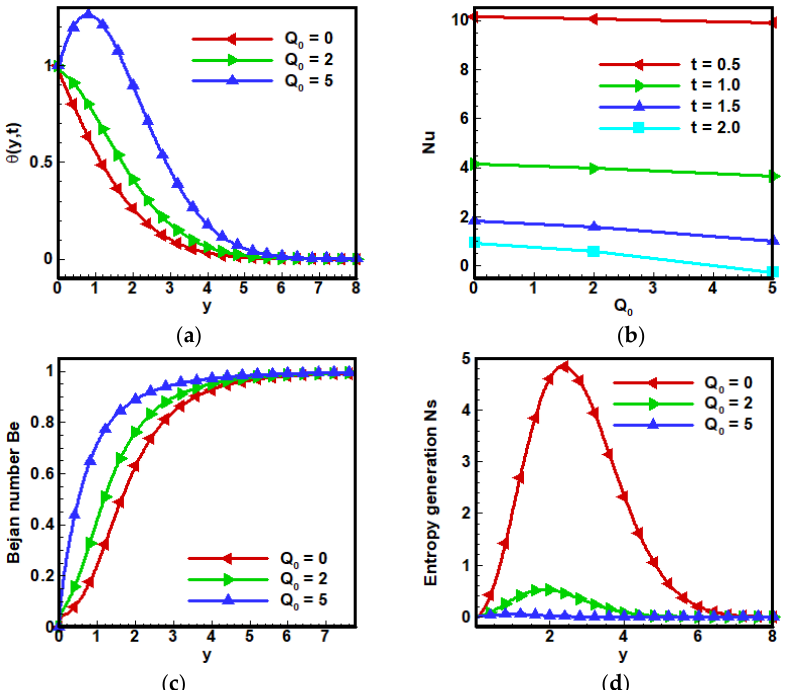
Figure 9. Influence of heat source 𝑄 (cid:2868) on ( a ) dimensionless velocity profile ( b ) non-dimensional tem- Figure 9. Influence of heat source Q 0 on ( a ) dimensionless velocity profile ( b ) non-dimensional perature profile ( c ) Bejan number and ( d ) entropy generation when Λ (cid:2869) = 0.6,Λ (cid:2870) = 0.5,𝐺𝑟 = 5,𝐻𝑎 = temperature profile ( c ) Bejan number and ( d ) entropy generation when Λ 1 = 0.6, Λ 2 = 0.5, Gr = 5, 10,Pr =6,𝑄 (cid:2868) = 5,𝑁𝑟 = 3.5,𝑎 = −1,𝐵𝑟 = 0.5,Ω = 10,𝜙 = 0.1 . Ha = 10,Pr = 6, Q 0 = 5, Nr = 3.5, a = − 1, Br = 0.5, Ω = 10, φ =